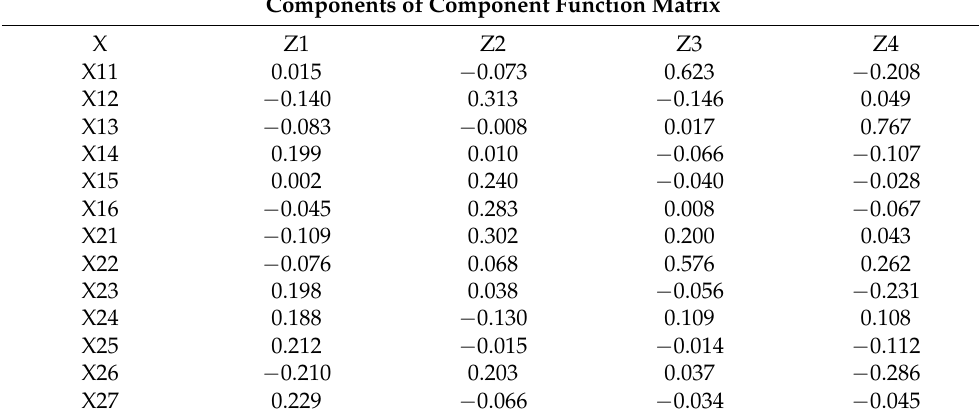
To calculate social vulnerability, we first calculated the principal component score function of each typical city according to the obtained component score coefficient matrix: